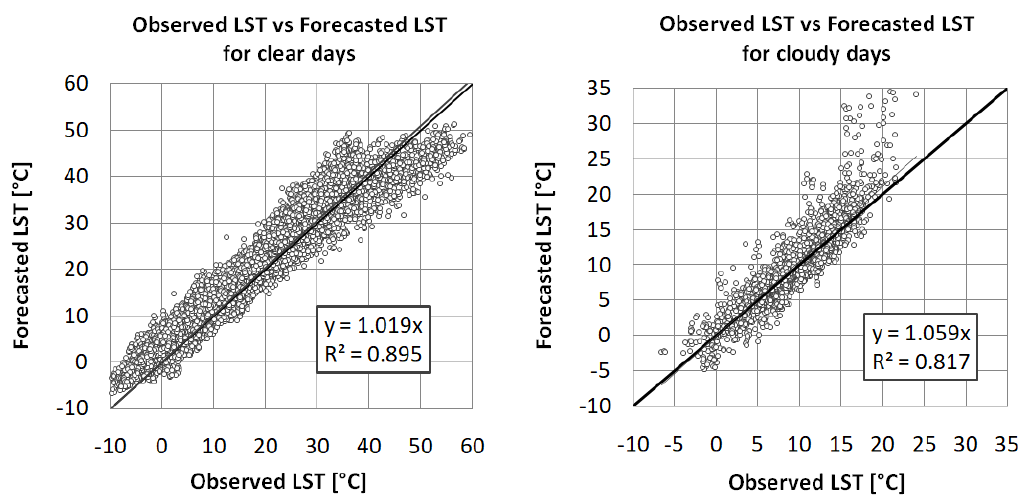
Figure 6. Scatterplot between observed vs. forecasted LST over the “Linate” station point during clear (left) and cloudy (right) sky days.